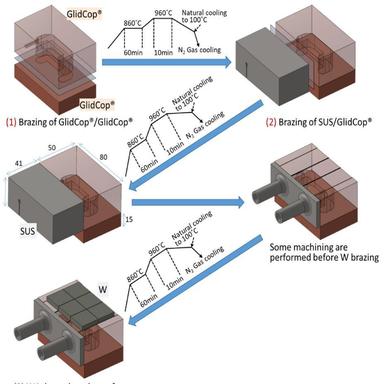
Schematic view of the fabrication test procedures (1e3) for the first AMSB divertor mock-up with heat treatment procedures.